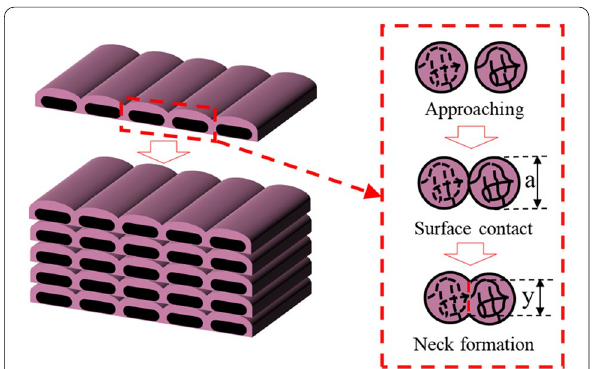
Figure 9 Formation process of the bonding neck during the printing process